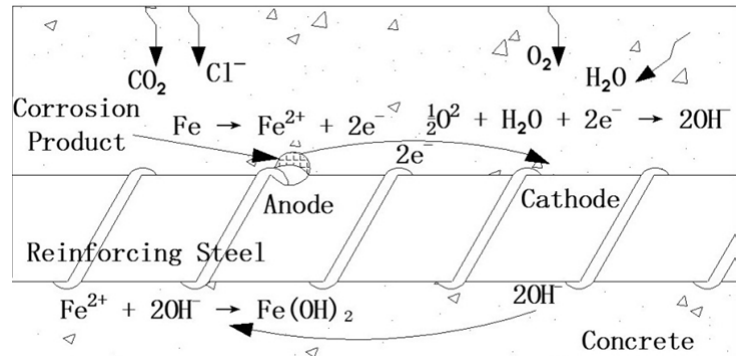
Figure 1. Schematic diagram of reinfo0rcing steel corrosion in concrete as an electrochemical